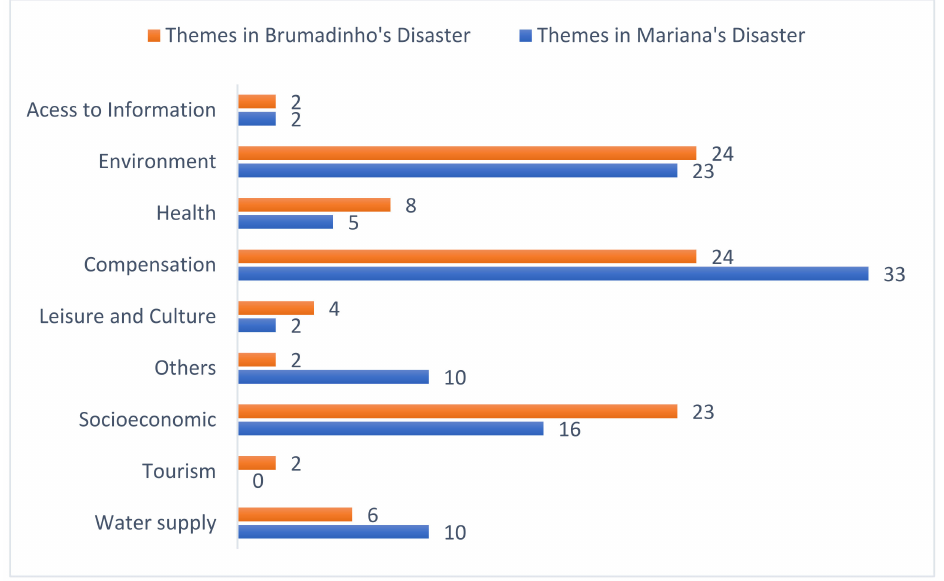
Figure 4. Relative distribution of themes in news reports.